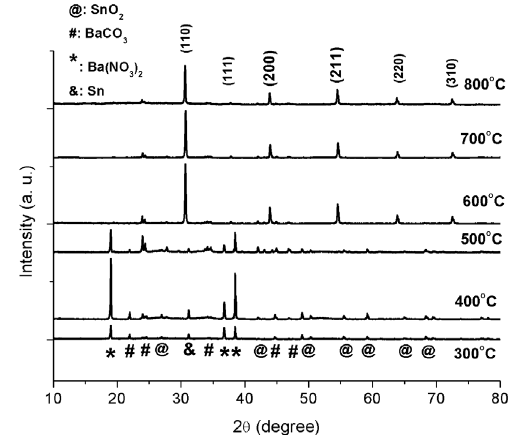
Figure 2. XRD patterns of the BaSnO temperatures.